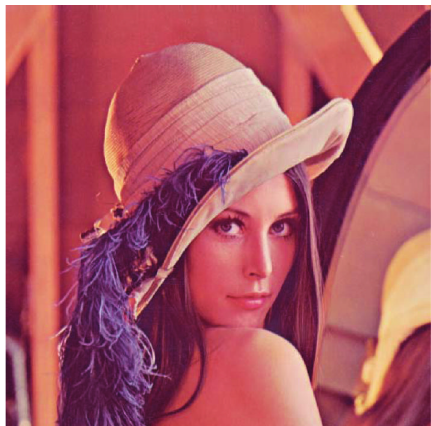
Figure 13: Lena 512 × 512 coded in RGB format at 16bpp per color